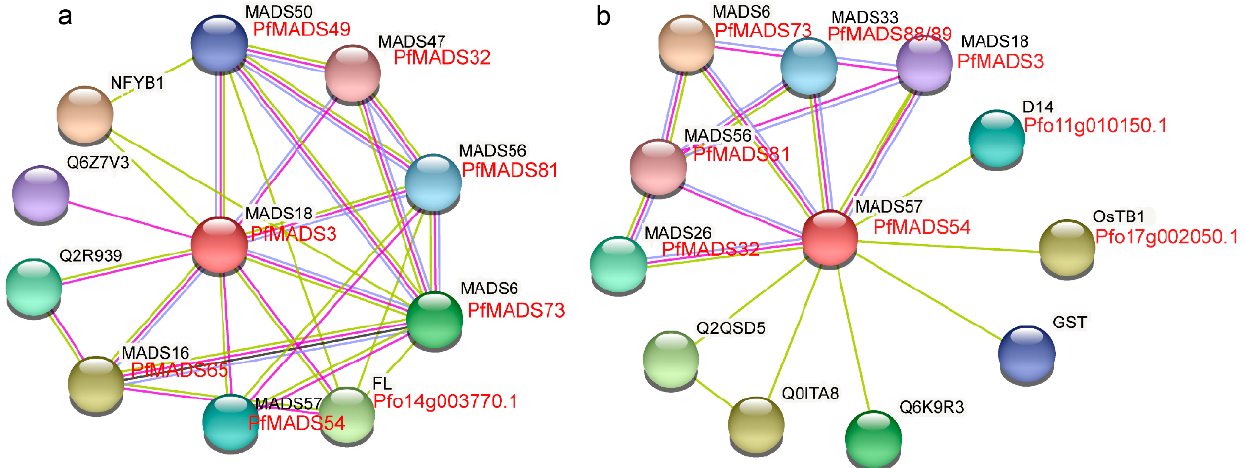
Figure 7. Protein–protein interaction network of PfMADS3 ( a ) and PfMADS87 ( b ). Circle nodes in the network represent proteins, and straight lines connecting the nodes represent interaction relationships. Indigo blue and purple lines indicate known interactions; green, red, and navy blue balls indicate predicted interactions; yellow, black and pearl blue indicate texting, co-expression, and protein homology interactions, respectively.